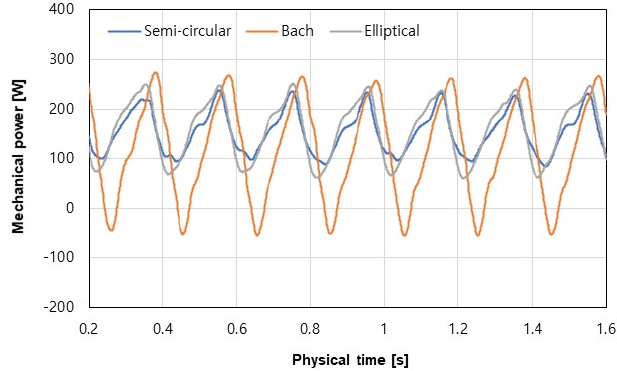
Figure 8. Rotor power according to rotor rotation position. Table 2. Comparison of average rotor power and efficiency according to rotor geometry.